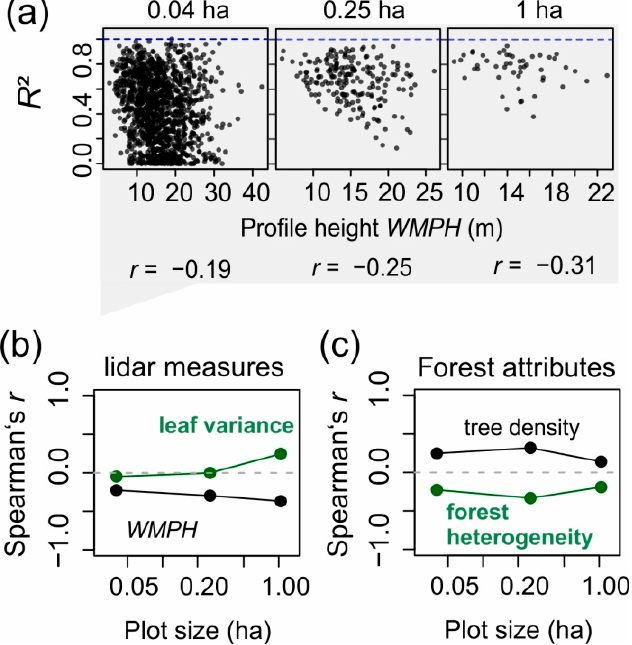
Figure 7. Correlations of R ² with characteristics of the lidar profile, forest attributes, and profile differences. In ( a ) correlations of R ² values and the mean profile height ( WMPH ) is shown at the 0.04-ha (left), 0.25-ha (middle) and 1-ha scale (right). Each black dot represents a forest plot, and the blue dashed lines reflect the optimal values for R ² (close to one). The correlation coefficients are displayed below (Spearman’s r ). In ( b–c ) the correlation coefficients are shown for each plot size: in ( b ) lidar-derived attributes (black: profile height WMPH , green: variance of leaf density) and in ( c ) forest attributes (black: tree density for d ≥ 1 cm, green: standard deviation of tree height). Grey dashed vertical lines show no dependence ( r = 0).